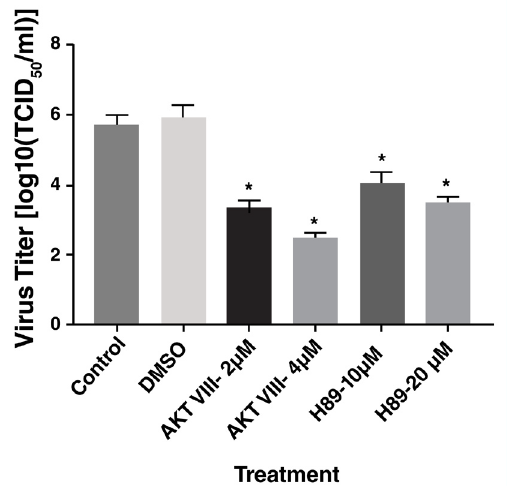
Figure 2. Effect of Pi3-akt signaling inhibitors on CHIKV replication. HPDF cells were pre-treated with inhibitors for 4–6 h and infected with CHIKV181/25. Significant reduction in virus titer was observed in the cells treated with AKT-VIII and